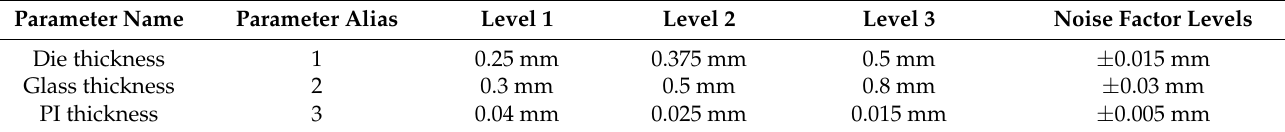
Table 3. Parametric model settings.